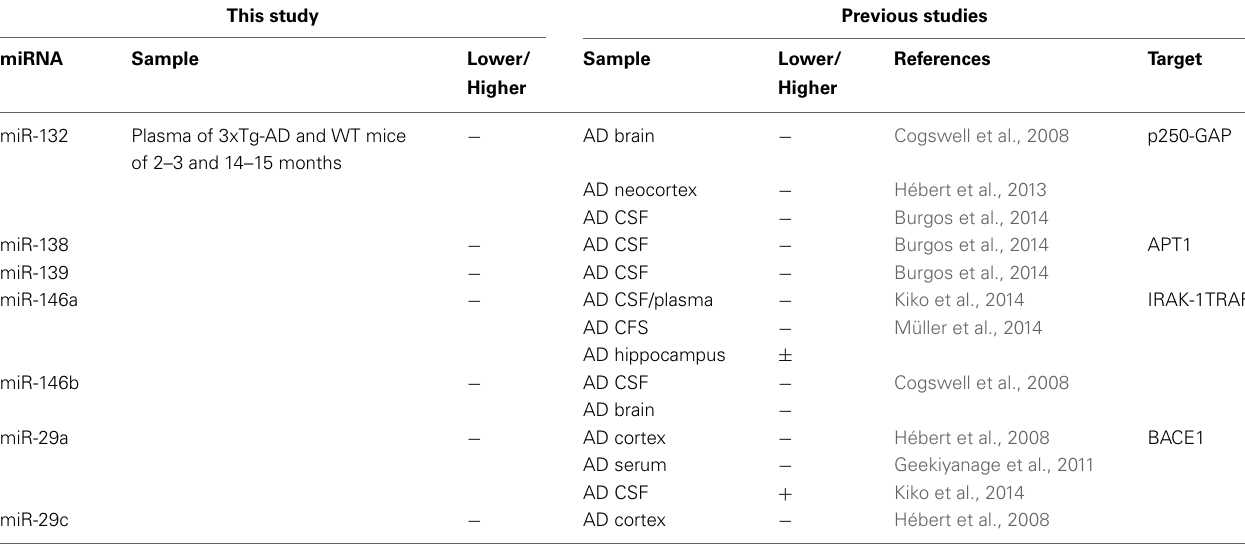
Table 1 | AD-like pathology-related miRNAs identified in this study and previously associated with